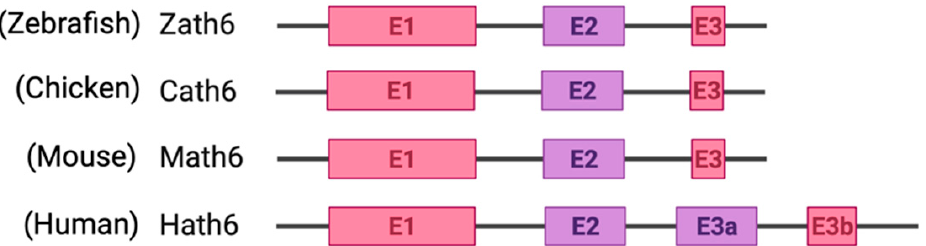
Figure 2. Schematic representation of exons and introns of Atoh8 in different orthologues. Zebrafish atonal homolog 6 (Zath6); Chicken atonal homolog 6 (Cath6); Mouse atonal homolog (Math6); Human atonal homolog 6 (Hath6).